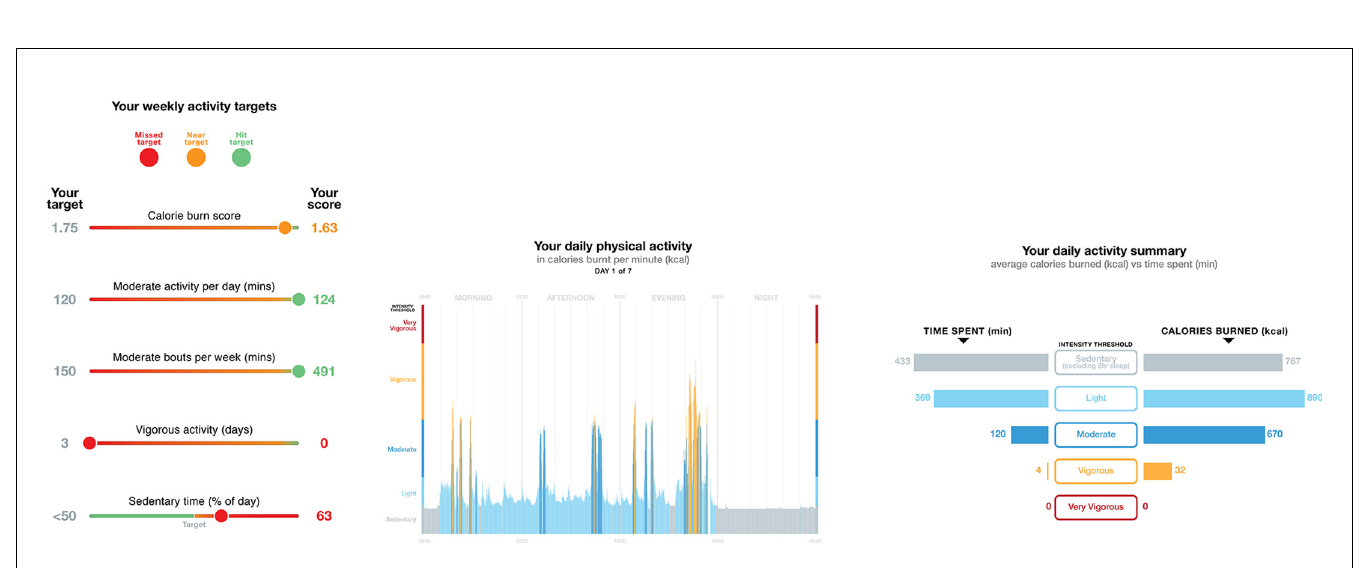
Figure 1. Examples of personalised feedback shown to participants. From left to right: health target attainment represented by traffic light colours across the five important health dimensions in a sliding scale format; a single day activity pattern colour graded by activity intensity; summary bar charts depicting the proportion of a given day spent in each intensity threshold and its resulting calorie expenditure